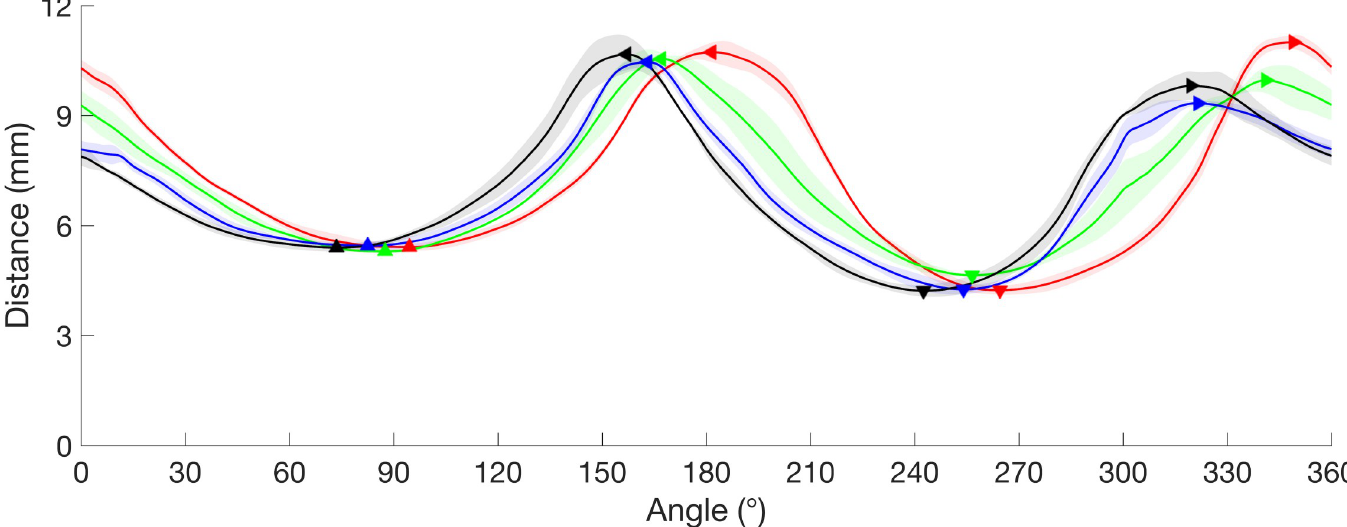
Fig 3. Quartile shape signatures of a representative carpal tunnel in neutral posture. The ensemble average ± standard deviation (shaded area) of the centroid-to- boundary distance shape signatures within quartiles where Q1 (proximal) is red, Q2 is green, Q3 is blue, and Q4 (distal) is black. Carpal tunnel width and depth were calculated as the summation of the medial ( ▶ ) and lateral ( ◀ ) peaks, and the palmar ( ▲ ) and dorsal ( ▼ ) troughs, respectively.